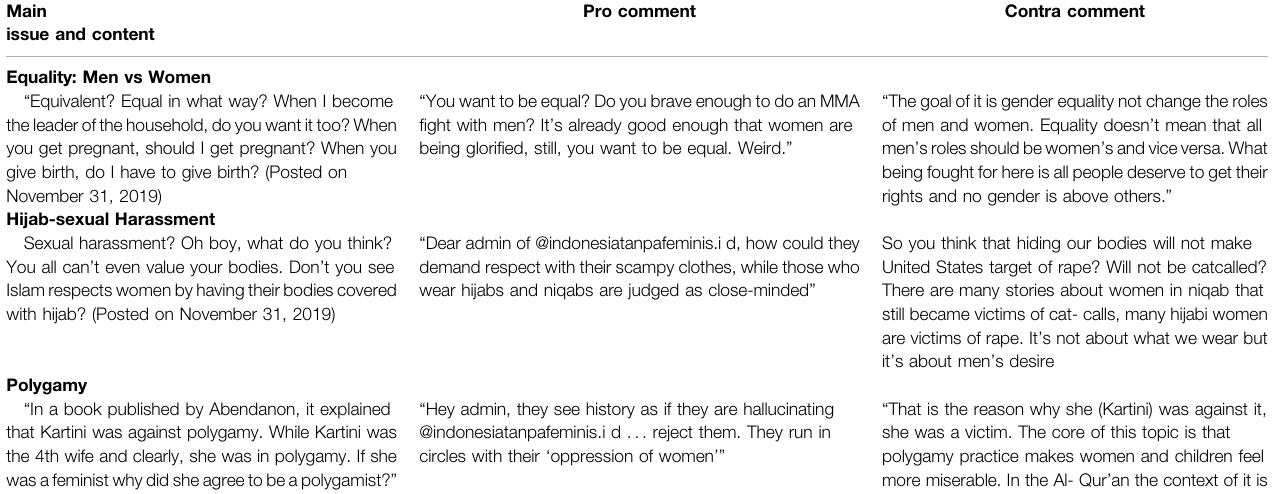
TABLE 1 | Discourse on interactionist between pro versus anti-feminist in